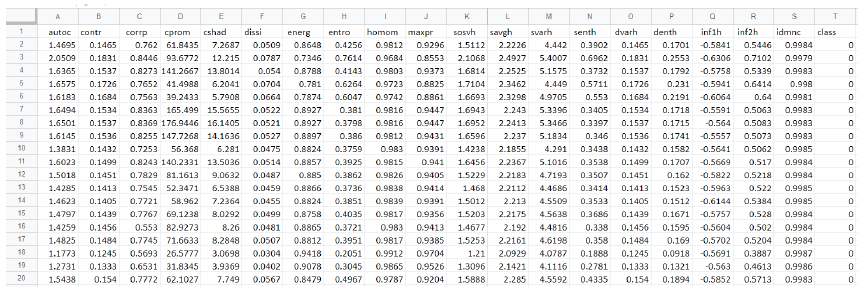
Figure 6. Features obtained for frames 1-20, as represented in the CSV